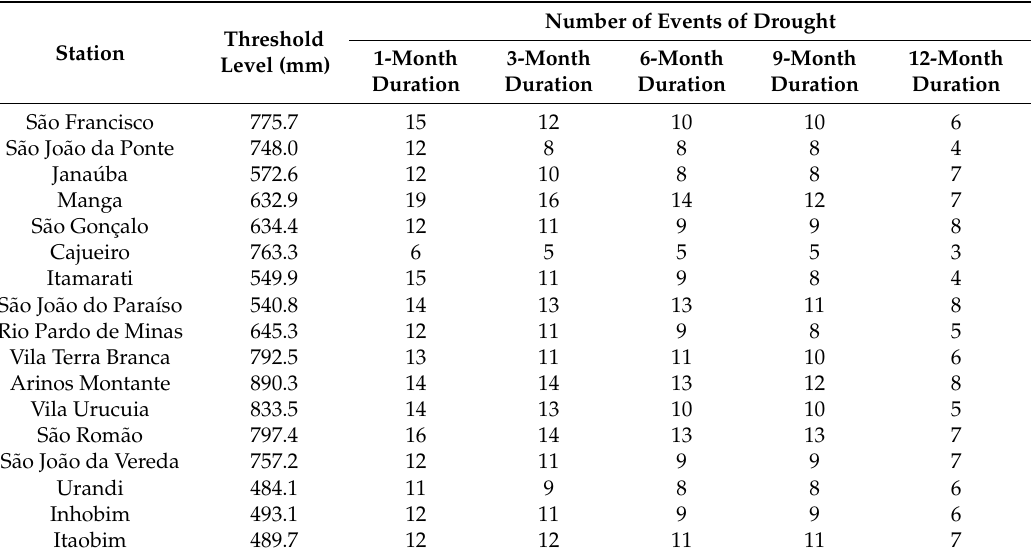
Figure 5. Twelve-month moving cumulative precipitation and drought events for S ã o Francisco station. Table 2. Threshold level and number of drought events for different durations